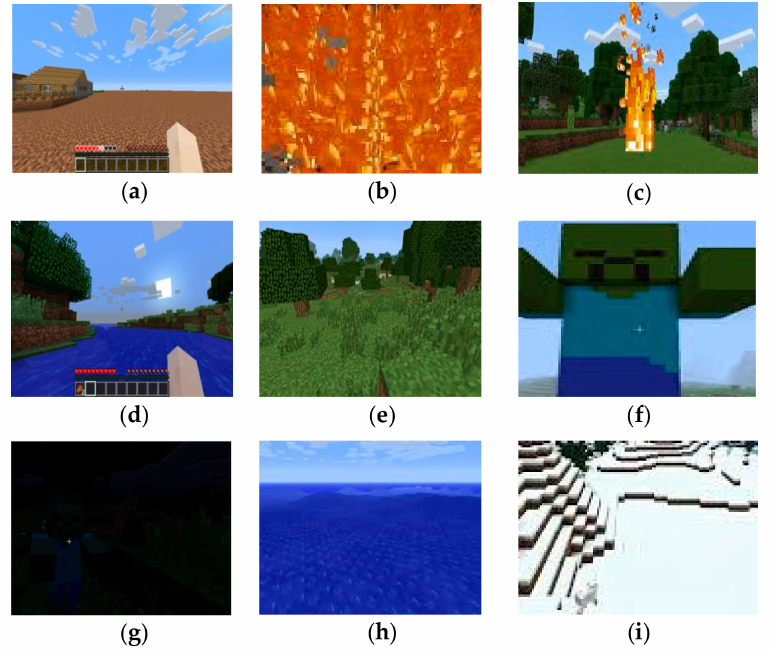
Figure 4. A sample of the training data used to train the model. ( a ) Dirt data; ( b ) Fire data; ( c ) Fire and grass data; ( d ) Grass and ocean data; ( e ) Grass data; ( f ) Mildew(zombie) data; ( g ) Mildew and grass data; ( h ) Ocean data; ( i ) Snow data.